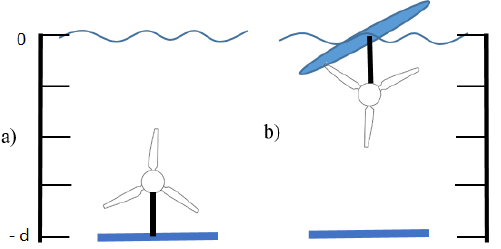
Figure 2. Turbine heights, for ( a ) a bed mounted turbine with hub height ( z hub ) at approx − 2/3 depth (d) and ( b ) a floating turbine position with z hub at approx − 1/3